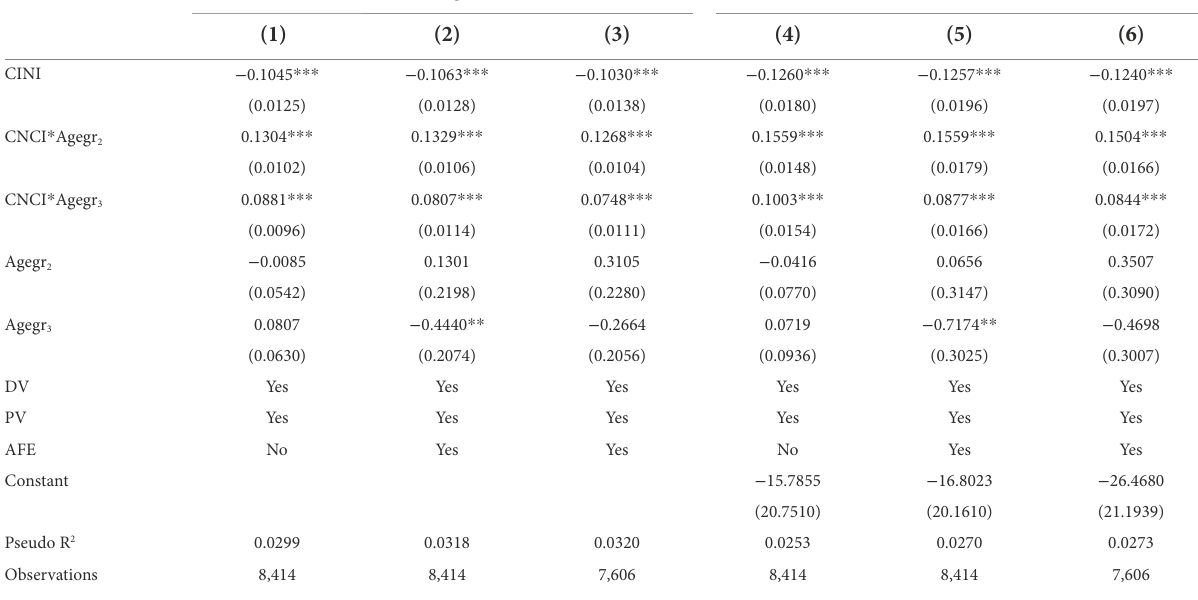
TABLE 9 Robustness test: Using other empirical models.